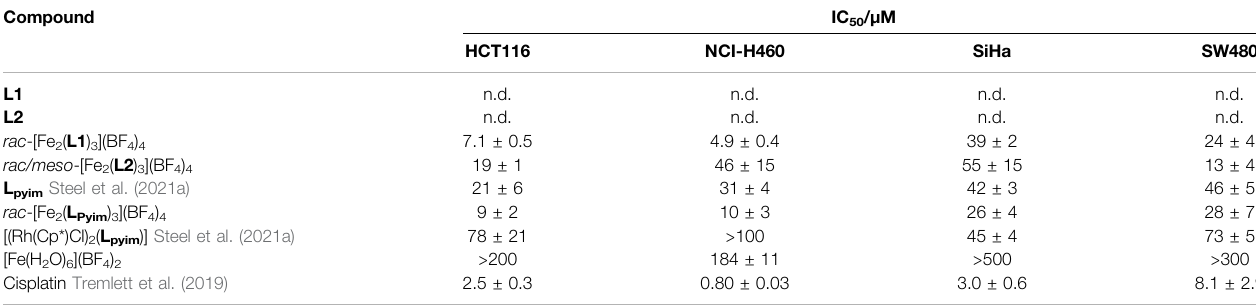
TABLE 1 | IC 50 values (µM) for L1 and L2 and the iron(II) cylinders against HCT116 (human colorectal carcinoma), NCI-H460 (human non-small cell lung carcinoma), SiHa (human cervical carcinoma), and SW480 (human colon adenocarcinoma) cancer cells as compared to cisplatin, expressed as mean ± standard error ( n (cid:1) 3, incubation period 72